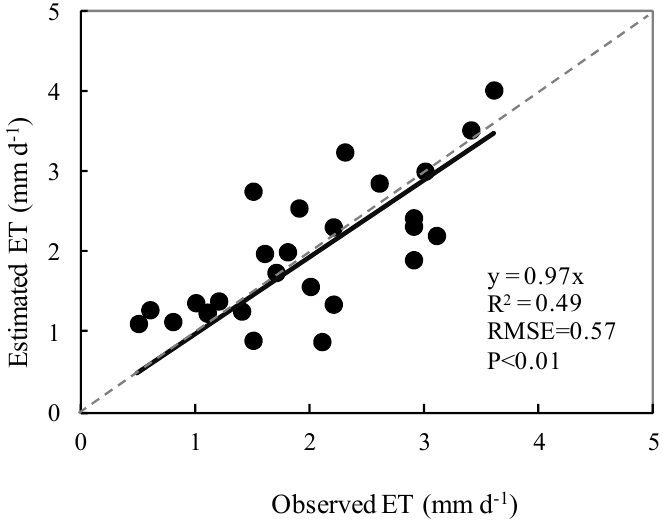
Figure 2. Comparison of evapotranspiration (ET) retrievals with field